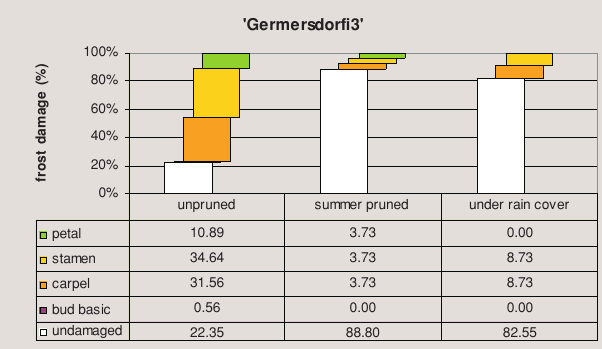
Figure 6. Frost damage in buds of the variety ’Germersdorfi3’ observed on